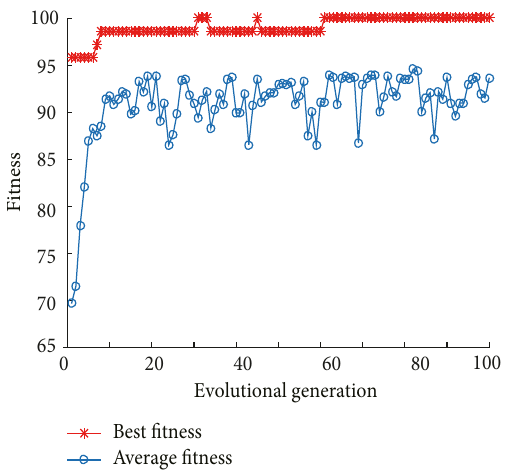
Figure 6: The GA optimization process of the optimal PCA-SVM